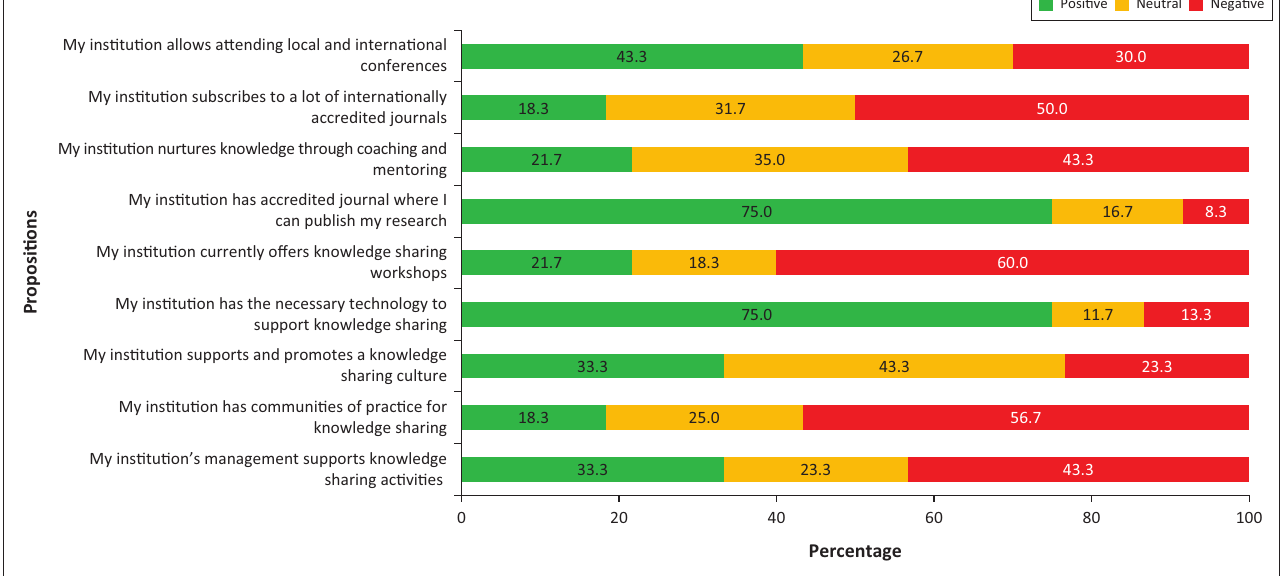
FIGURE 3: Knowledge-sharing practices for innovation in higher education ( n =